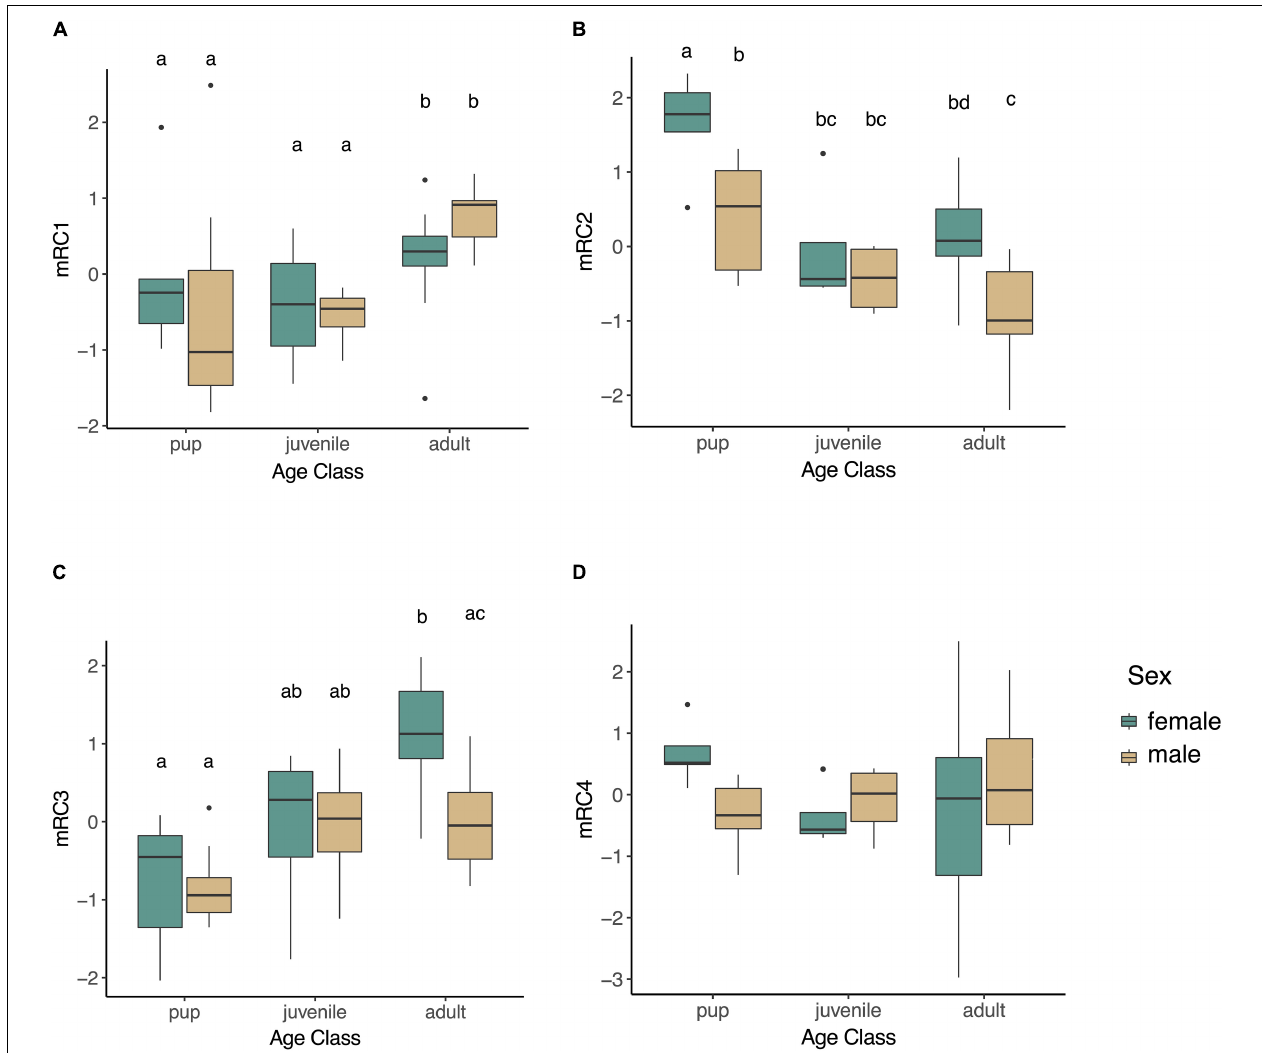
FIGURE 4 | Boxplots showing expression of rotated components mRC1 ( A ; GPX4 , PRDX6 , PRDX1 , SIRT1 ), mRC2 ( B ; PGC1A , ESRRA , ESRRG ), mRC3 ( C ; HMOX1 , BVR , GPX3 , PRDX1 ), and mRC4 ( D ; HMOX2 , NRF2 , IL1B ) in skeletal muscle of NES. mRC1 varied by age ( F 2 , 42 = 5.31, p = 0.0088), while mRC2 and mRC3 varied by age and sex (mRC2: F 4 , 41 = 14.26, p < 0.0001; mRC3: F 2 , 39 = 3.13, p = 0.055). Different letters denote significant differences between groups (GLM followed by post hoc EMM test, p <